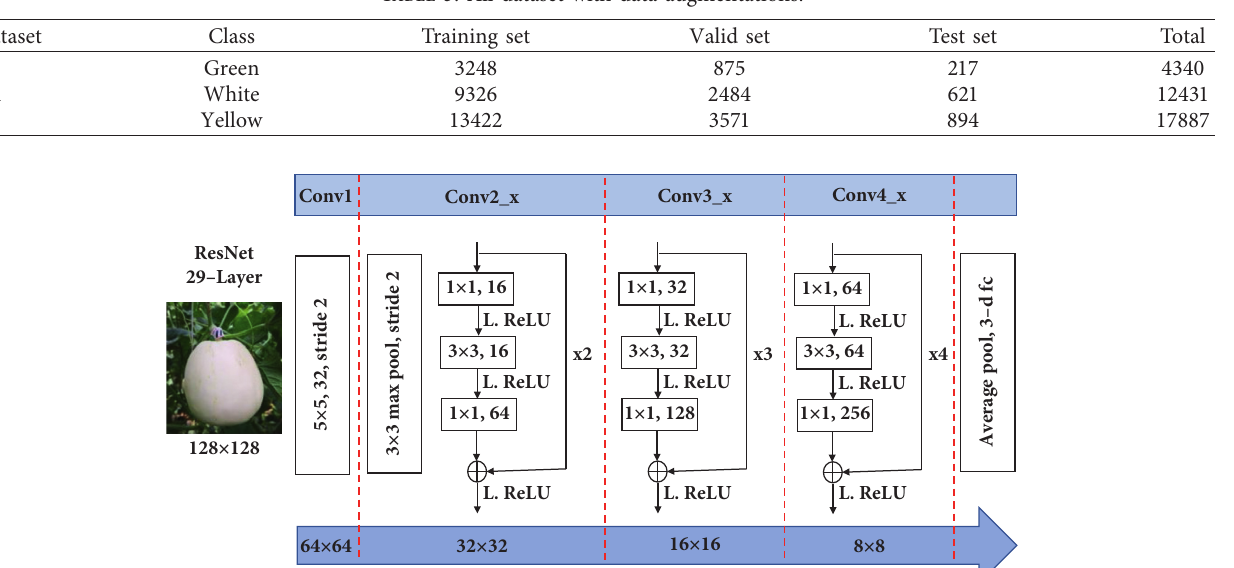
Table 5: All dataset with data augmentations.